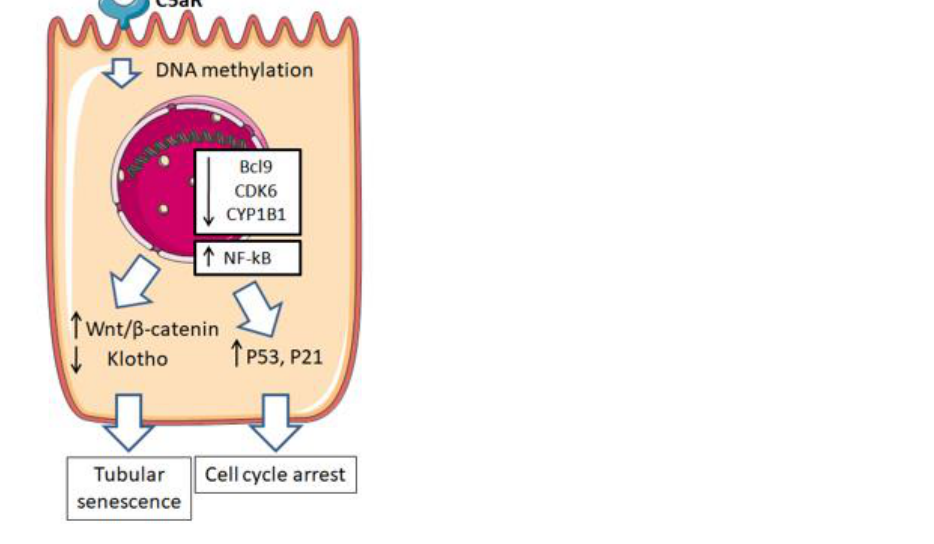
Figure 2. Complement activation induces epigenetic modifications in renal tubular epithelial cells